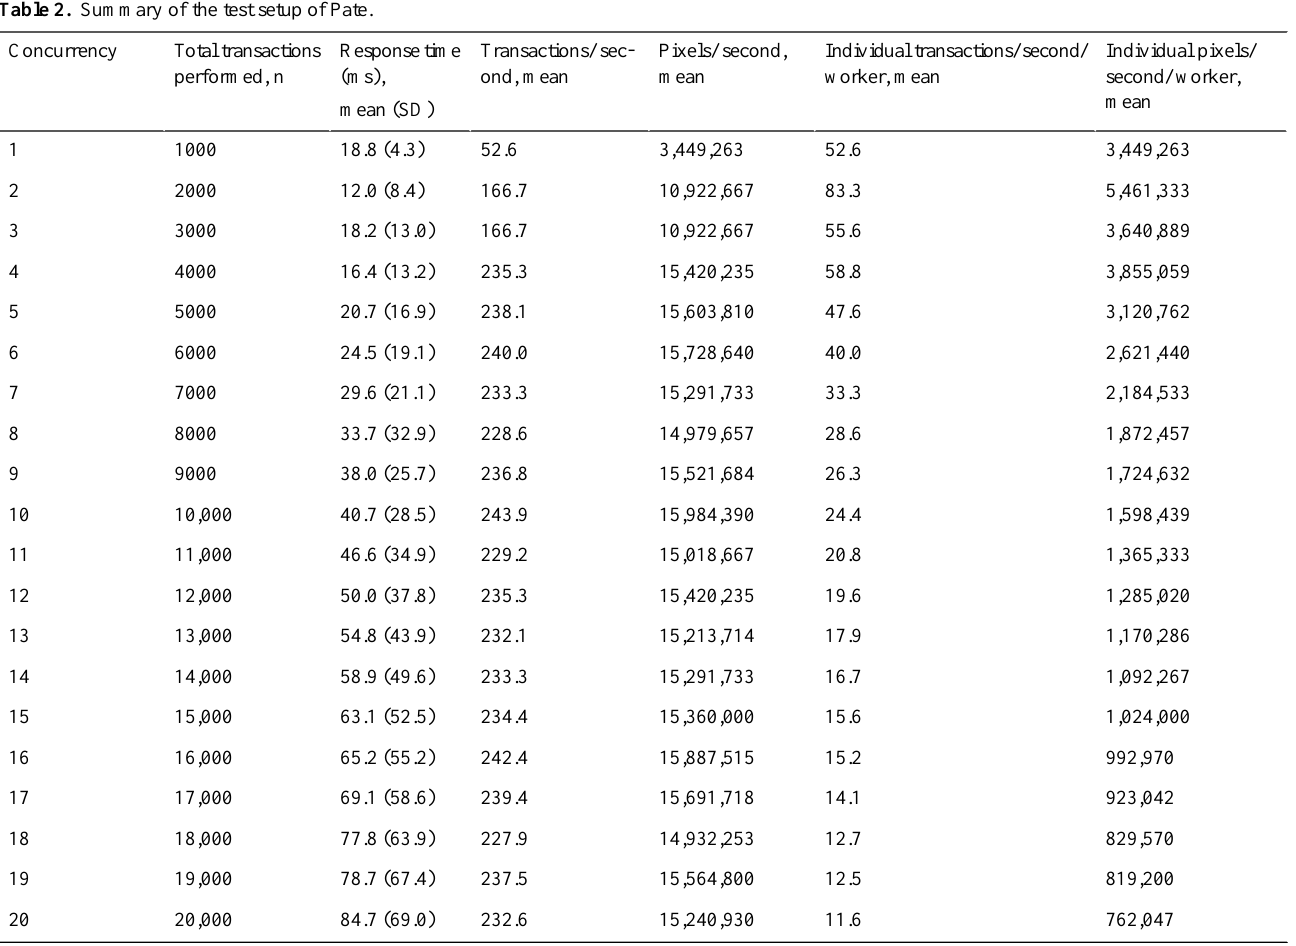
Table 2. Summary of the test setup of